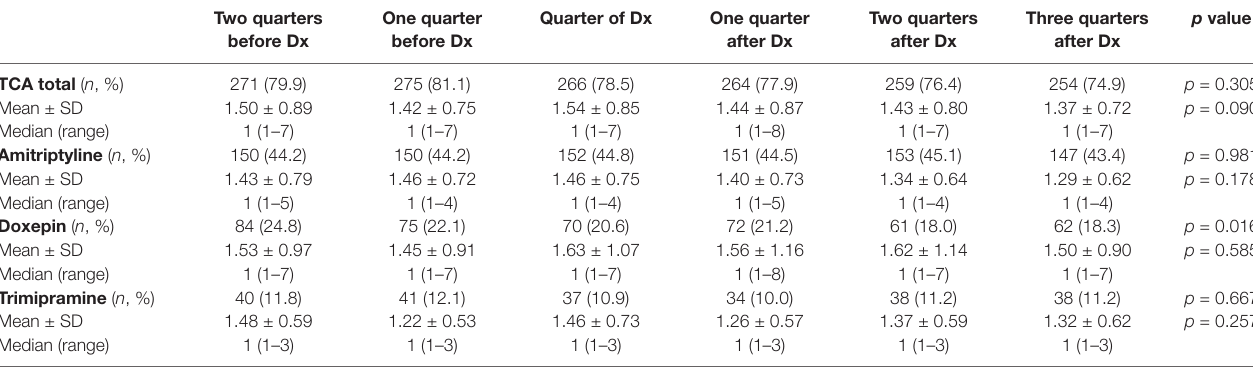
TABLE 1 | Dispensing of tricyclic antidepressants (TCA) over two quarters before and four quarters after the diagnosis of dementia in Q3 or Q4 of 2014 ( n = 339). Two quarters One quarter before Dx before